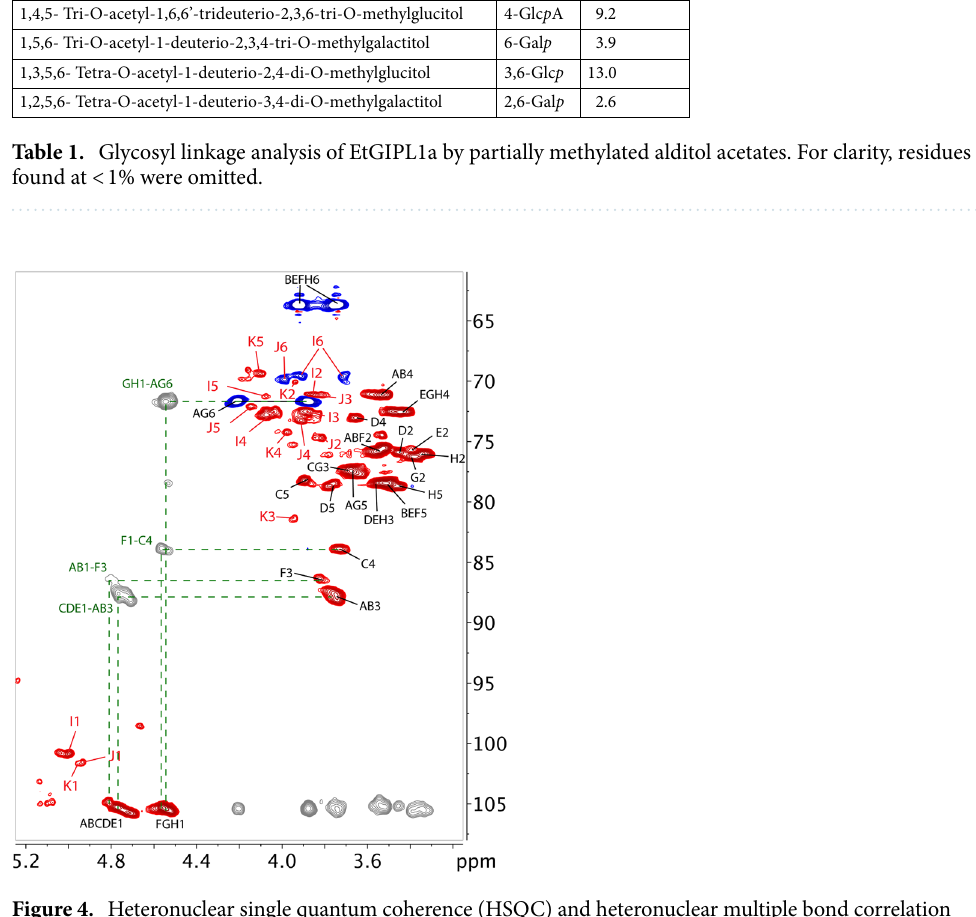
Figure 4. Heteronuclear single quantum coherence (HSQC) and heteronuclear multiple bond correlation (HMBC) NMR analysis of EtGIPL1a. Partial multiplicity-edited 1 H- 13 C-HSQC NMR spectrum of EtGIPL1a [red (CH groups) and blue (CH 2 groups) peaks] and partial 1 H- 13 C-HMBC NMR spectrum (grey peaks, only correlations with anomeric protons/carbons are shown for clarity) of EtGIPL1a. Red labels indicate signals that were of much lower intensity in the EtISPFa sample 5 (see Table 2), and green lines and labels indicate HMBC